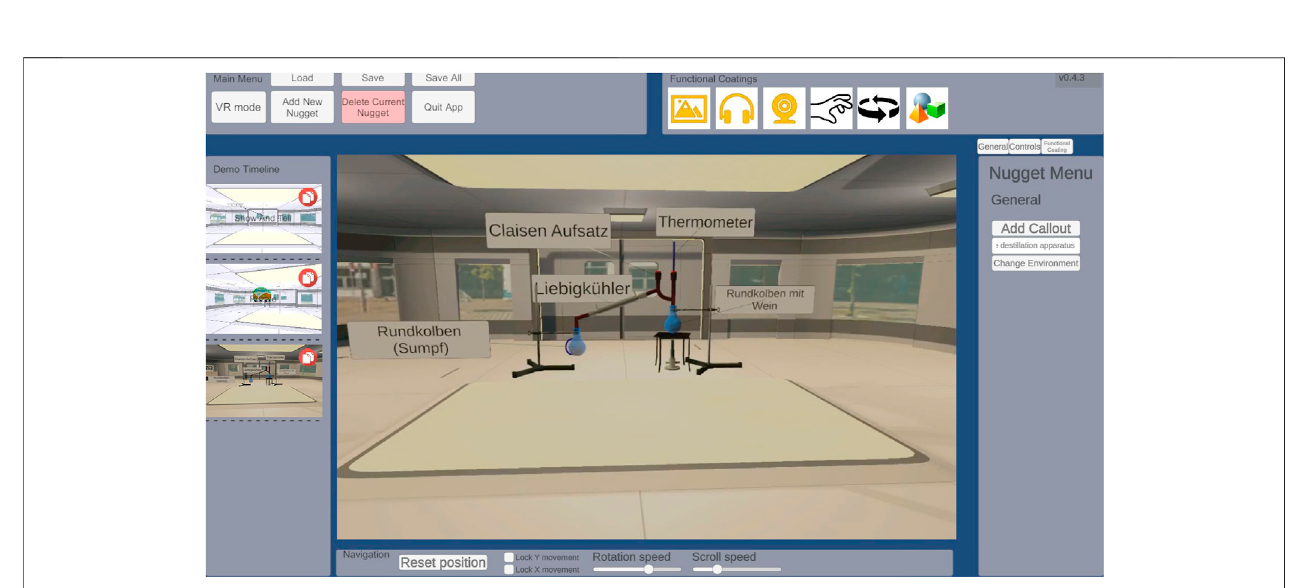
FIGURE 3 | Illustration of VR Forge ’ s UI using the example of a VR nugget for a wine distillation practical used within a chemicals lecture.